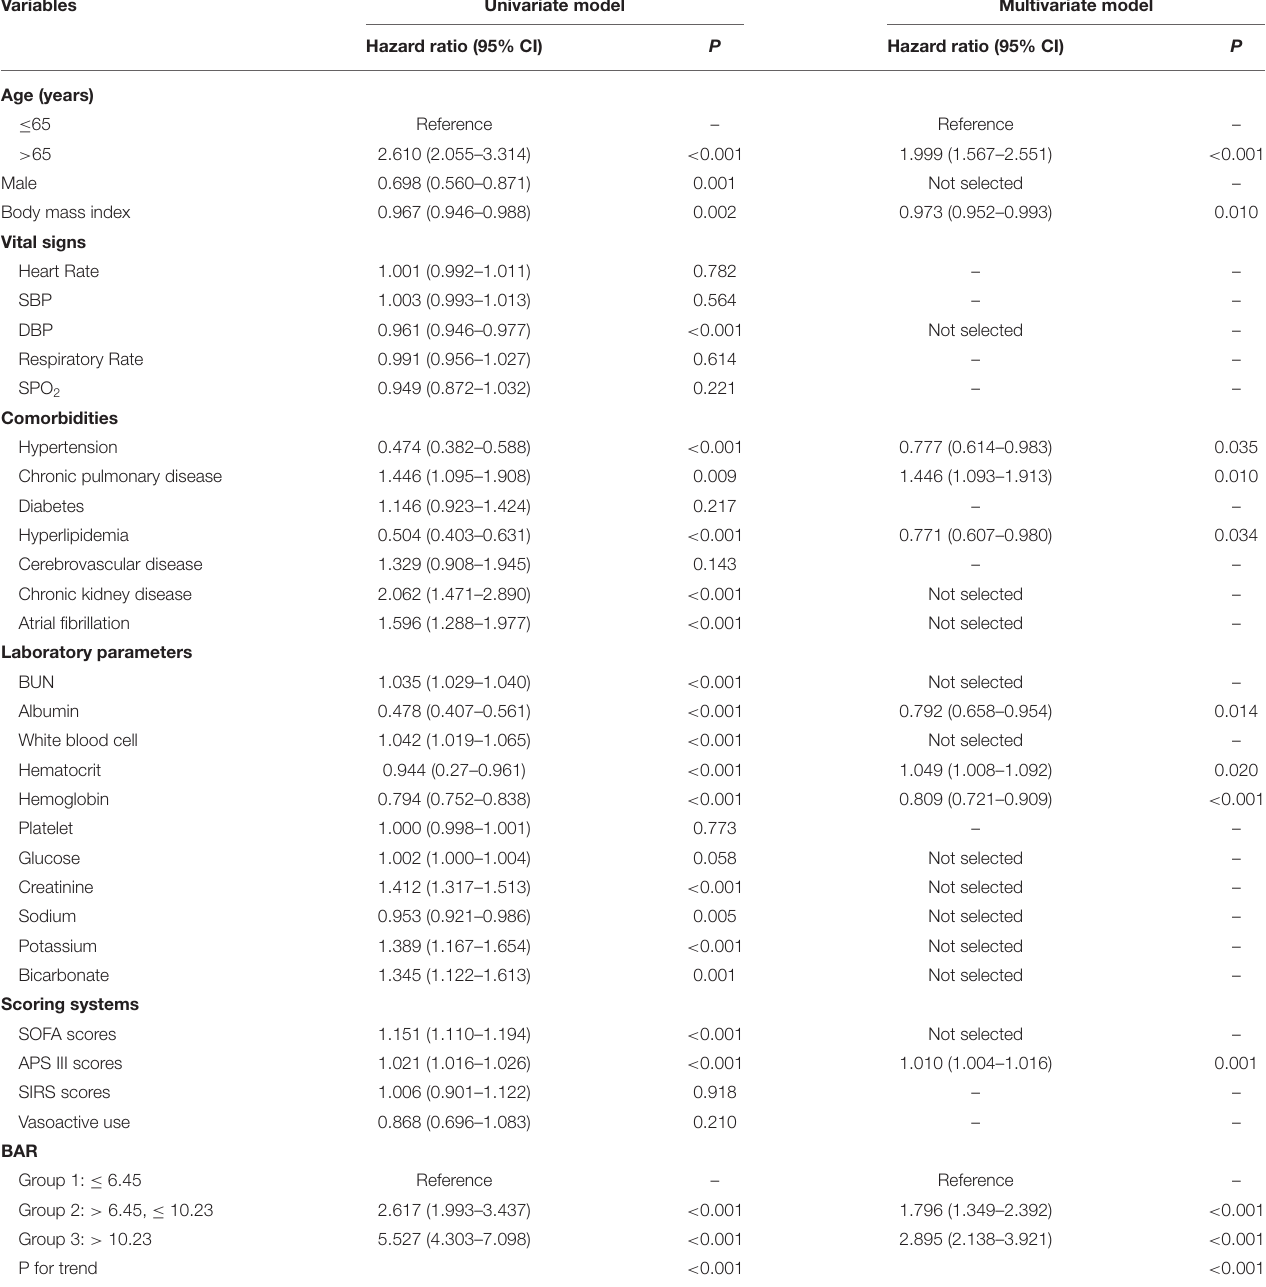
TABLE 3 | Cox proportional hazard models exploring the association of BAR with 4-year